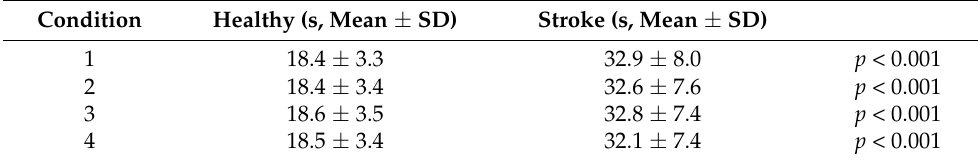
Table 2. Mean scores of L Test in all